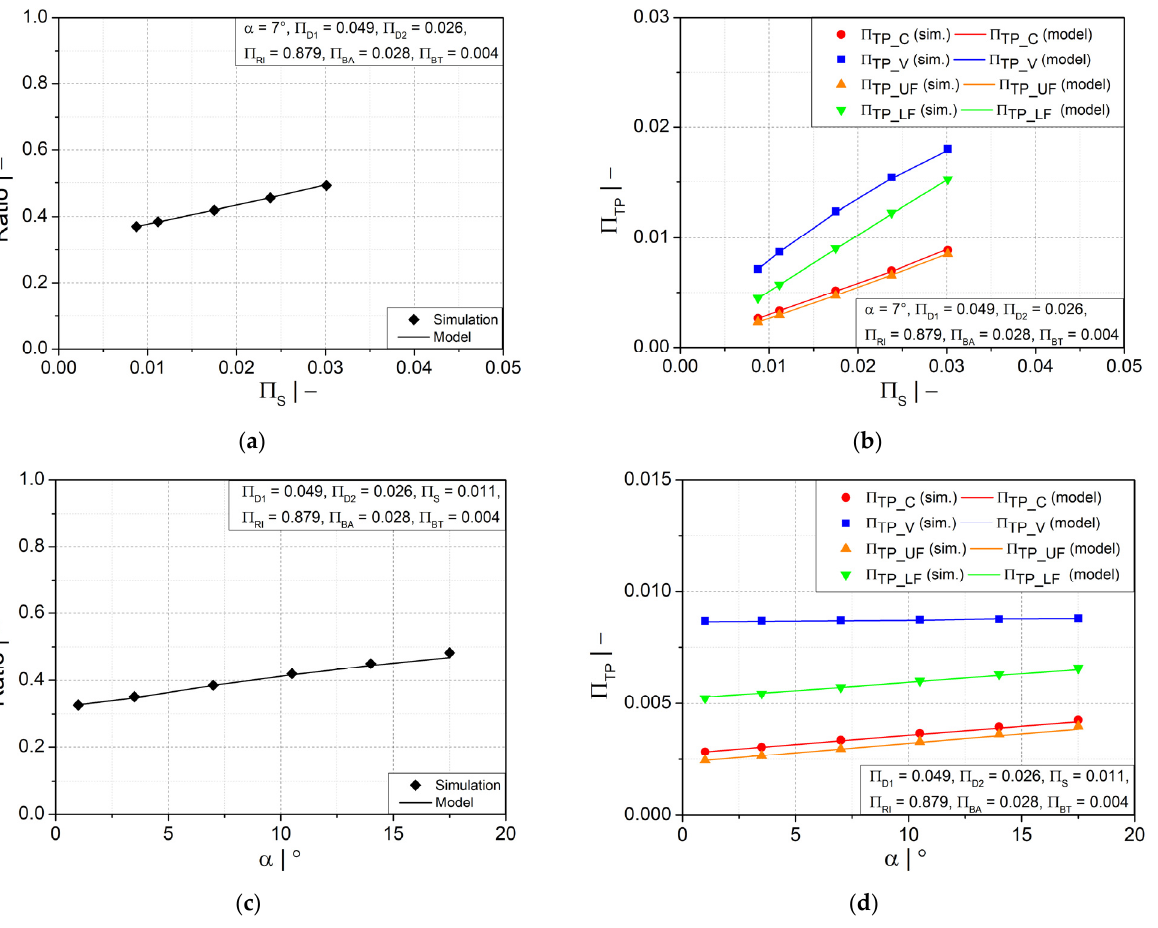
Figure 14. Comparisons of the estimated models for wall thickness distribution ratio and dimensionless wall thickness at several evaluation positions as functions of ( a , b ) dimensionless initial thickness of fluid parison ∏ S and ( c , d ) flank angle α